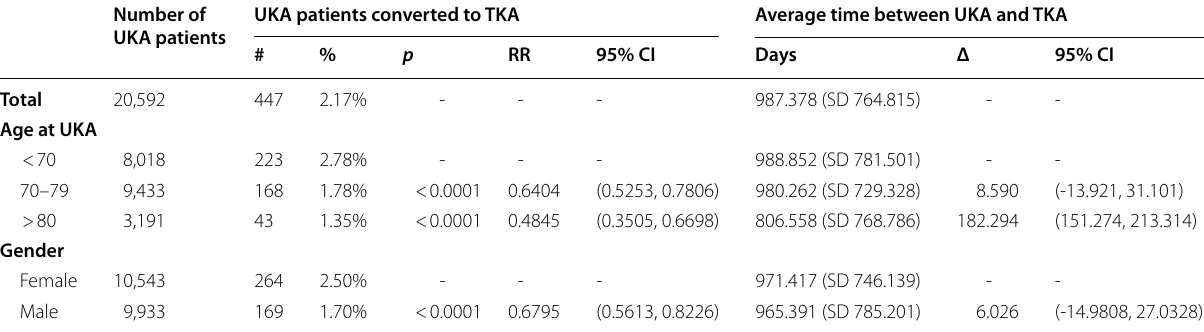
Table 10 Time betwen UKA and TKA for patients undergoing conversion Number of UKA patients